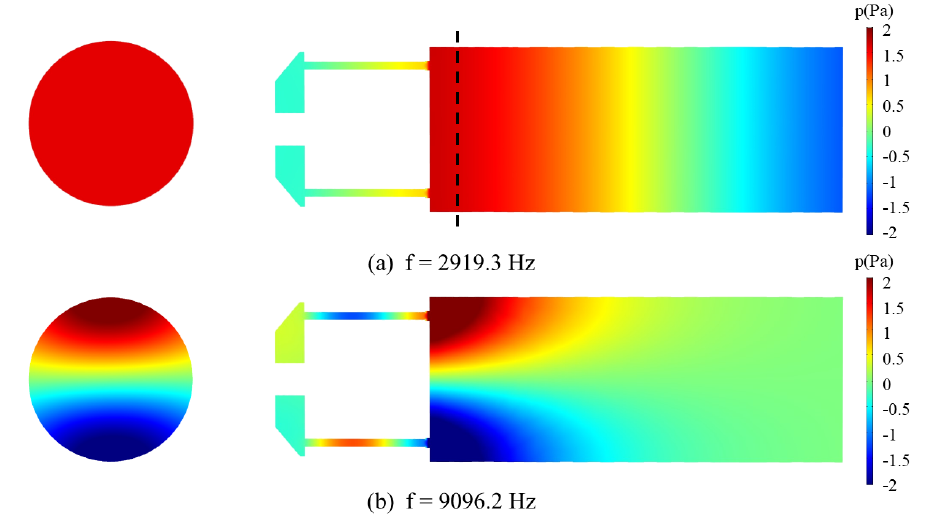
Figure 7. Pressure mode-shapes of ( a ) the first longitudal and ( b ) the first transverse thermoacoustic mode. The contour map of the cross-sectional surface is at 0.015 m. Herein, n =